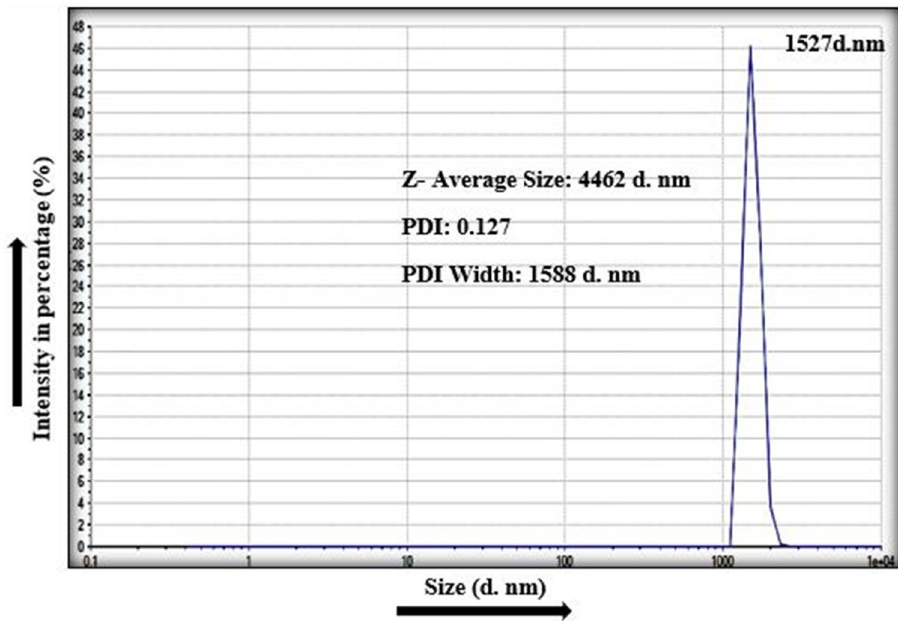
Figure 9. Dynamic light scattering study of SeNPs synthesized from Citrus limon (Lemon) fresh peels